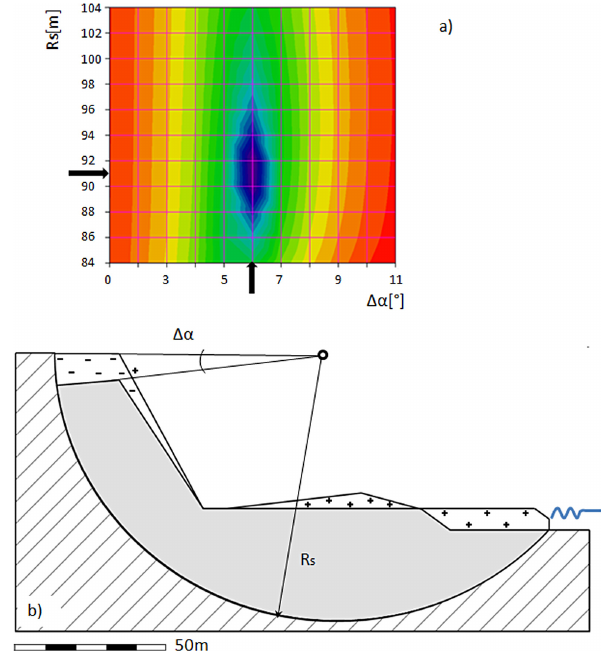
Fig. 6. Single slider block model. (a) Grid search for optimum parameters: L2-norm for different radii to sliding plane (Rs) and rotation angle ( 1α) , the minimum is marked by arrows; (b) the optimum single slider block